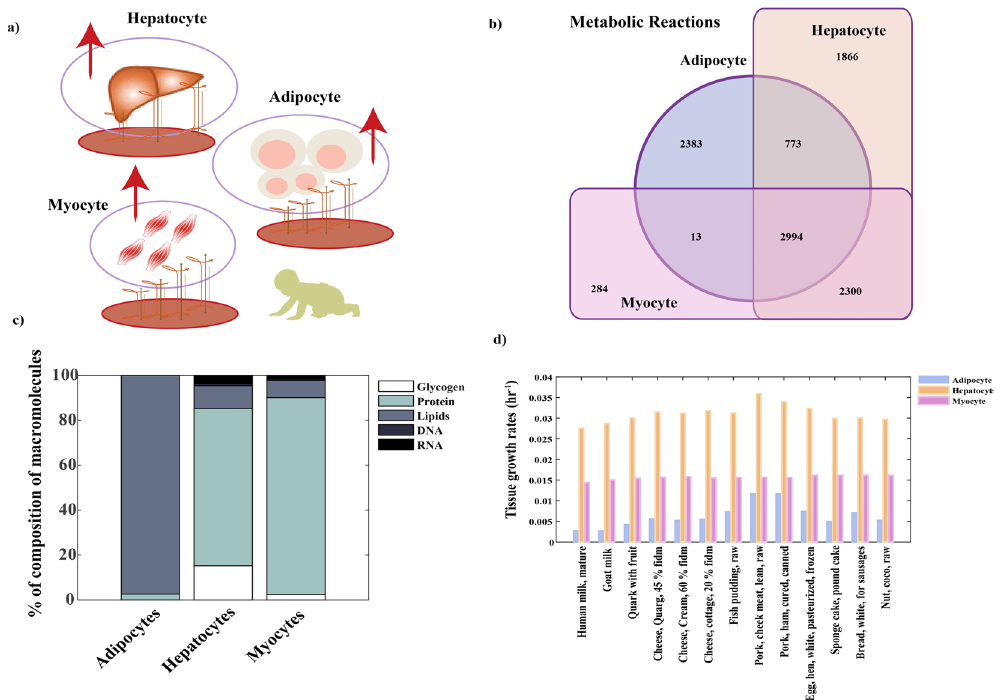
Figure 4. ( a ) Representation of different tissue models (GEMs) included in the analysis. ( b ) Similar or different metabolic reactions contained in the models. ( c ) Percentage of tissue composition and its macro-molecular contents ( d ) Growth rates (hr − 1 ) of hepatocytes, myocytes and